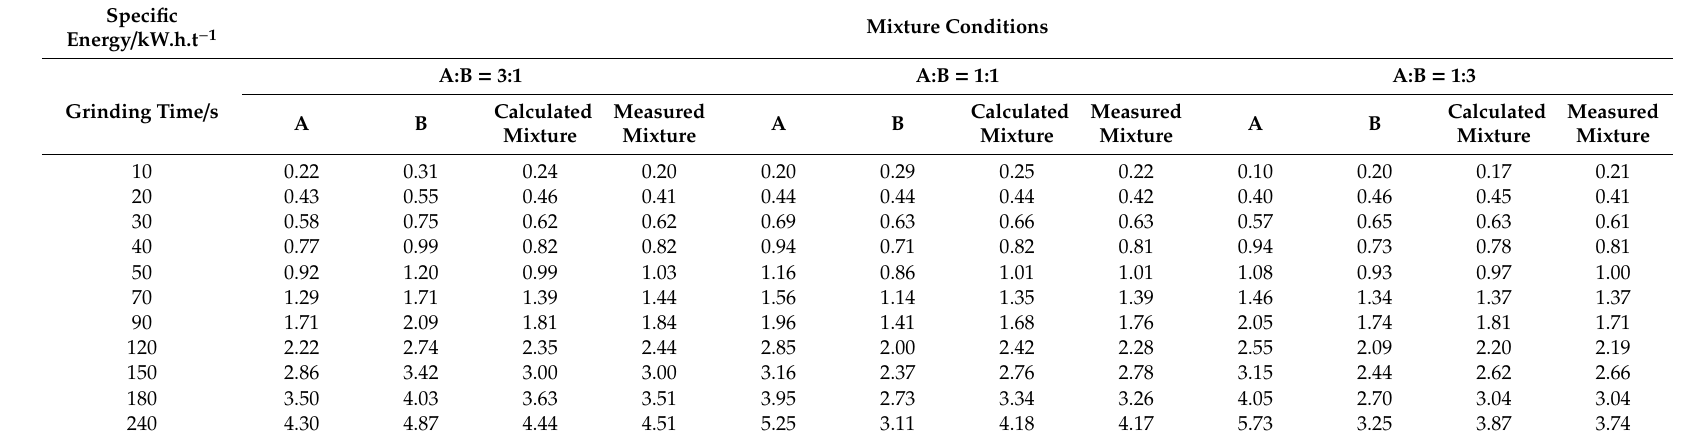
Table 4. Specific energies of components at various grinding conditions and times.